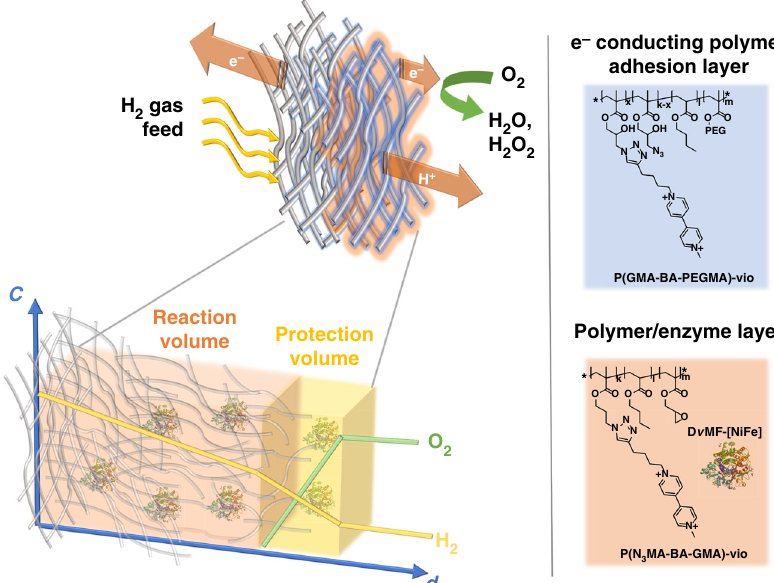
Fig. 1 Schematic of the proposed gas-breathing polymer-based bioanode. The hydrogenase is electrically wired to the electrode surface via the viologen- modi fi ed redox polymers P(N 3 MA-BA-GMA)-vio (poly(3-azido-propyl methacrylate- co -butyl acrylate- co -glycidyl methacrylate)-viologen) and P(GMA- BA-PEGMA)-vio (poly(glycidyl methacrylate- co -butyl acrylate- co -poly(ethylene glycol) methacrylate)-viologen, blue). The latter acts additionally as adhesion layer for the P(N 3 MA-BA-GMA)-vio/hydrogenase reaction layer (pale red) due to its more hydrophobic character that enhances interactions with the hydrophobic surface of the carbon cloth gas diffusion electrode and prevents direct contact of the biocatalyst with the electrode surface, hence protecting the enzyme from high-potential deactivation (in combination with P(N 3 MA-BA-GMA)-vio) as well as unwanted contribution from DET. At the polymer/electrolyte interface incoming O 2 is scavenged by the reduced polymer-bound viologen moieties (protection volume, yellow, left bottom). Expected normalized concentration pro fi les for H 2 (yellow) and O 2 (green) under turnover conditions are shown at the bottom (left) of the scheme illustrating protection from O 2 (with c = concentrations and d = distance from electrode). O 2 is reduced at the outer polymer/enzyme layer and hence the reaction layer remains unaffected. The porous structure of the carbon cloth-based electrode ensures a high polymer/biocatalyst loading and minimizes limitations due to slow electron transfer by keeping the electron transfer pathways short (see main text for further details). Note that the reaction as well as the protection layer contains the redox polymer and the biocatalyst. Not drawn to scale. Dv MF-[NiFe] = [NiFe] hydrogenase from Desulfovibrio vulgaris Miyazaki F (4U9H) 41 . PEG poly(ethylene